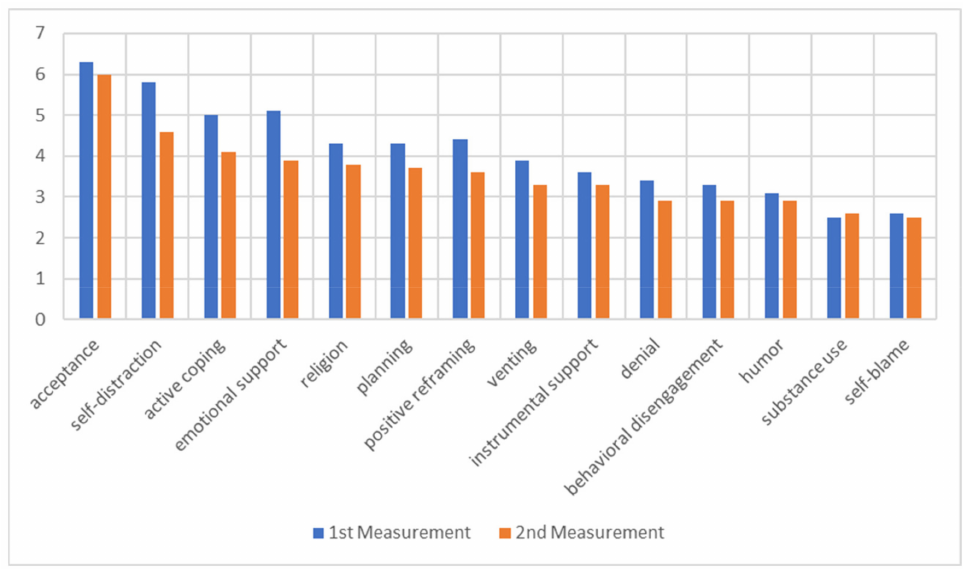
Figure 2. The average scores on individual coping strategies (the Brief COPE) in overall sample (range of